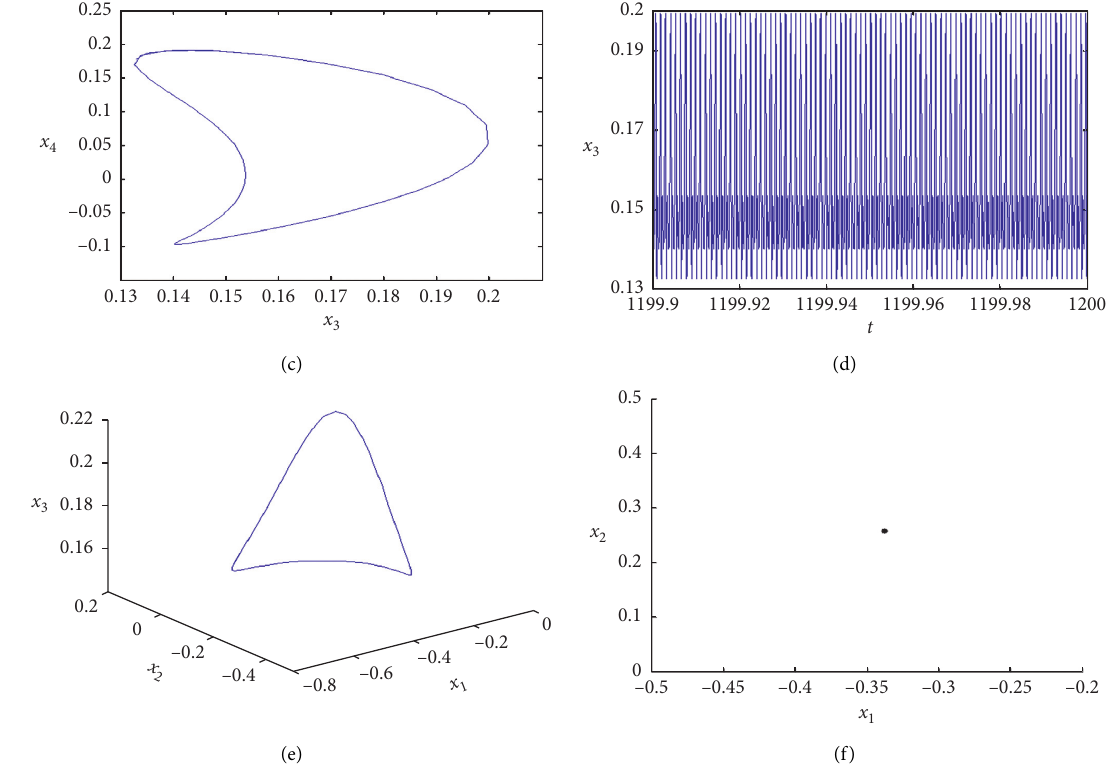
Figure 13: The period-1 oscillation of the cantilevered pipe conveying pulsating fluid is obtained when the parametric excitation of the flow � 42 . 5. (a) Phase portrait on plane ( x velocity is U 0 ) , (e) three-dimensional phase portrait in space ( x on plane ( t, x 3